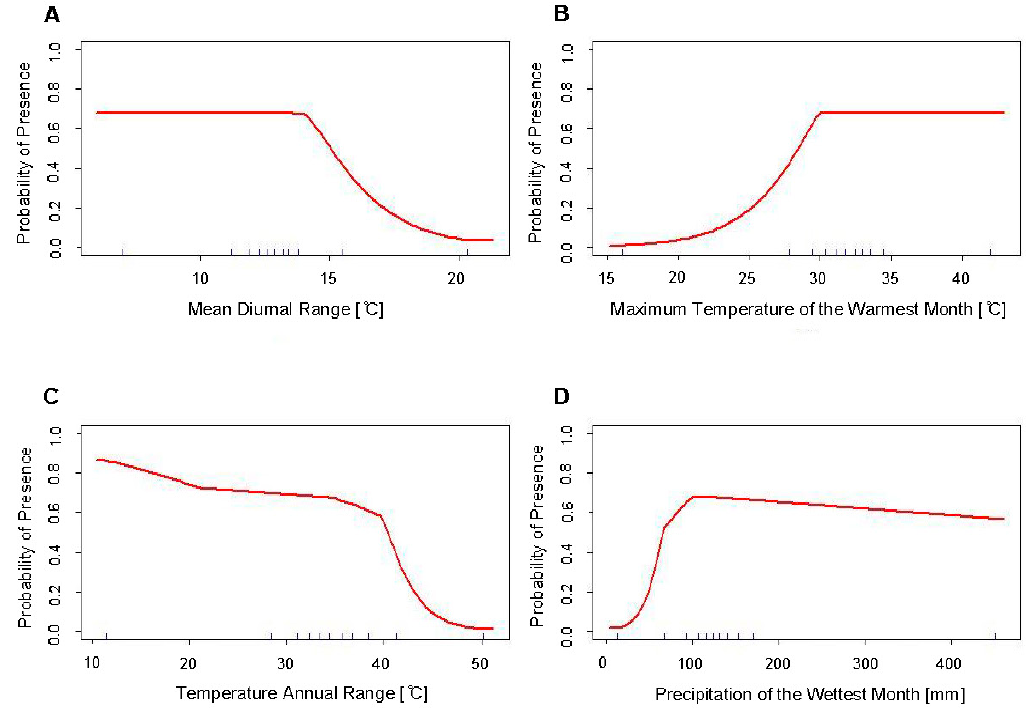
Figure 6. Response curves of the variables used in the final SDMs of Ae. albopictus (Model 2b) using occurrence records excluding VZL data, showing predicted habitat suitability to ( A ) mean diurnal range (Bio2), ( B ) maximum temperature of the warmest month (Bio5), ( C ) temperature annual range (Bio7) and ( D ) precipitation of the wettest month (Bio13).